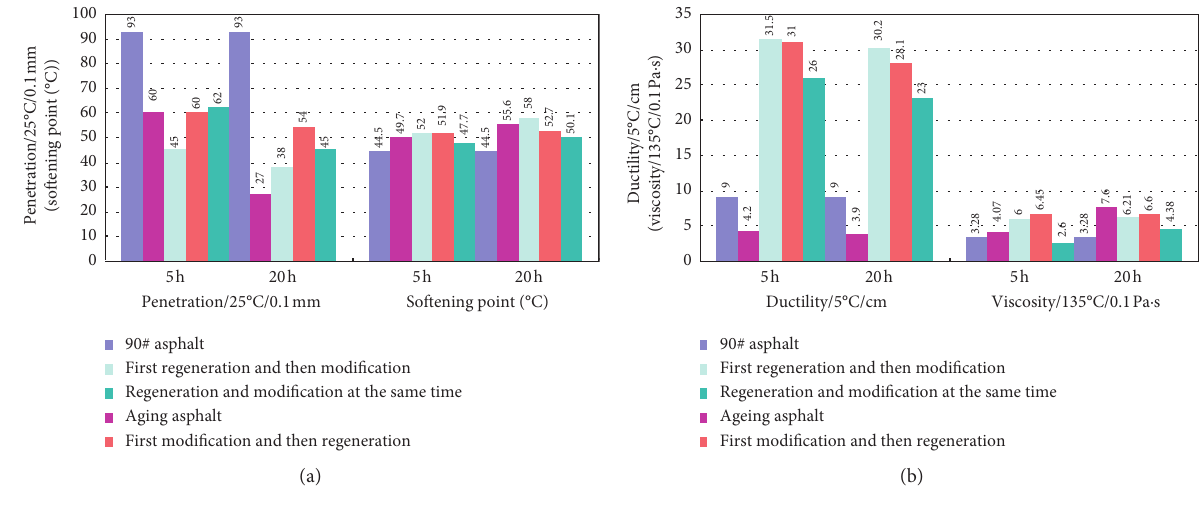
Figure 9: Index relationships of aging asphalt regeneration and modification. Table 13: Results of asphalt component